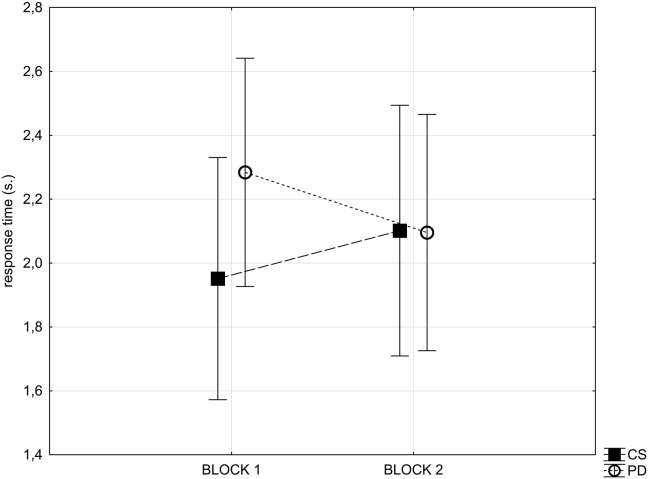
Effects of PD on RTs. This figure illustrates the RTs compared across the patients with PD and the matched control group (CS) for block one and block two of the experimental task. The group with PD displayed a trend towards slower response in block one. Bars represent standard error of the mean.